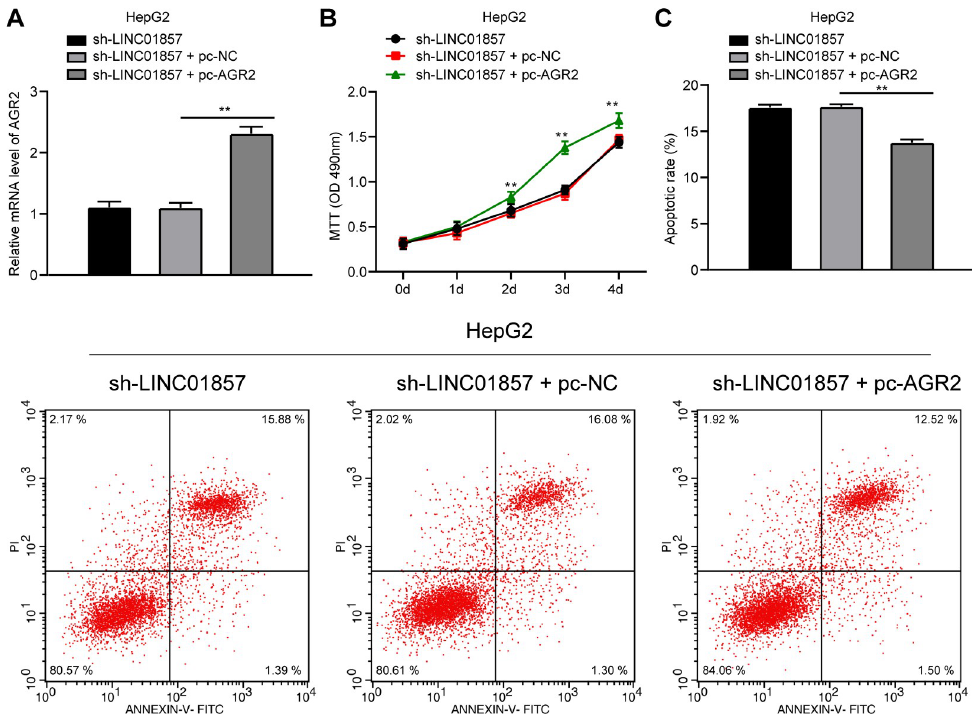
Fig 5. AGR2 overexpression attenuates the effect of silenced LINC01857 on reducing HCC cell proliferation and improving apoptosis. pcDNA-AGR2 was transfected into HepG2 cells with silenced LINC01857, with pcDNA-NC as NC. A, pcDNA-AGR2 transfection efficiency detected by RT-qPCR. B, cell proliferation measured by MTT. C, apoptosis examined via flow cytometry. Three independent repeated tests were conducted. The results were presented as mean ± standard deviation. One-way ANOVA was used to analyze the data in panel A. Two-way ANOVA was used to analyze the data in panels B and C. Tukey’s multiple comparisons test was applied for the post hoc test. �� p < 0.01.